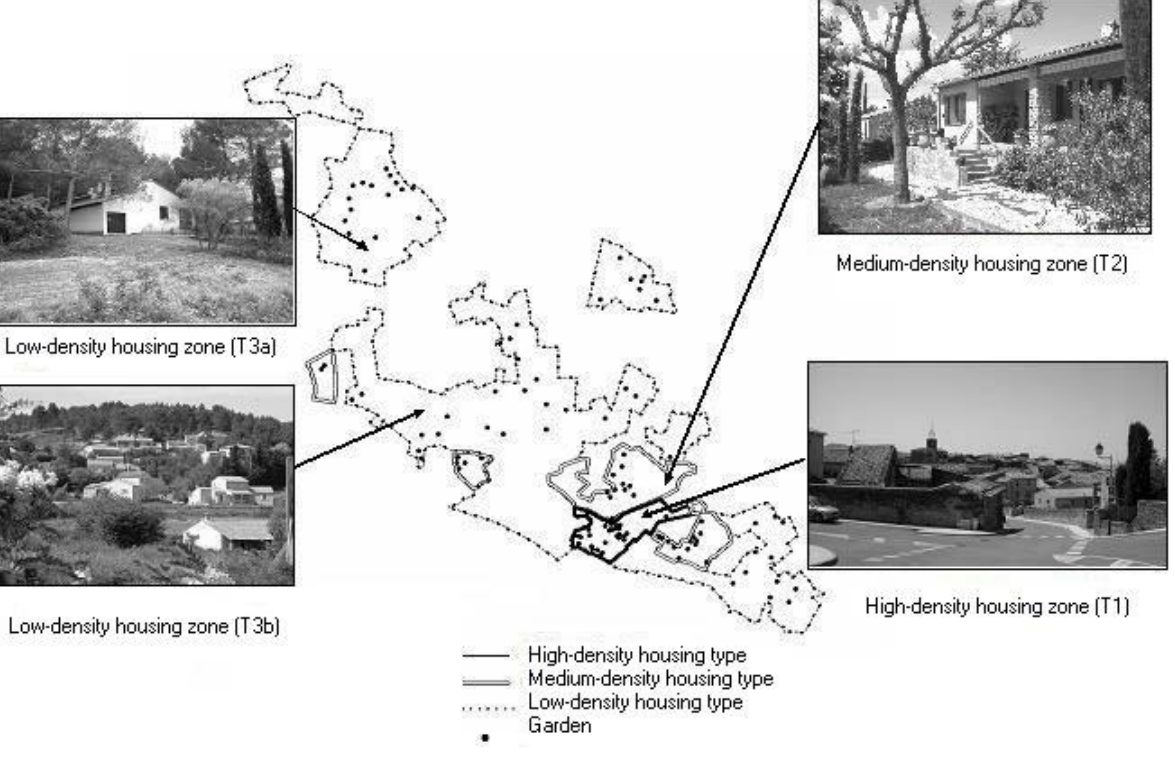
Fig. 2. Housing density map and location of the 120 study gardens in Lauris, France. High-density housing type (built-up area < 20%) corresponds to the center of Lauris (T1); medium-density housing type (built-up area 10%–20%) corresponds to two residential areas close to the center (T2); low-density housing type (built-up area < 10%) corresponds to villas scattered in pine forest (T3a) or built on fallow land